Question: Judging by this figure, is the value going up or going down?
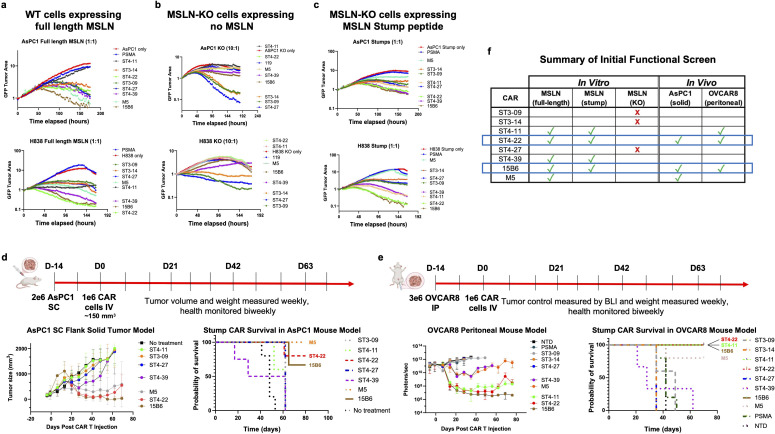
Answer: increasing